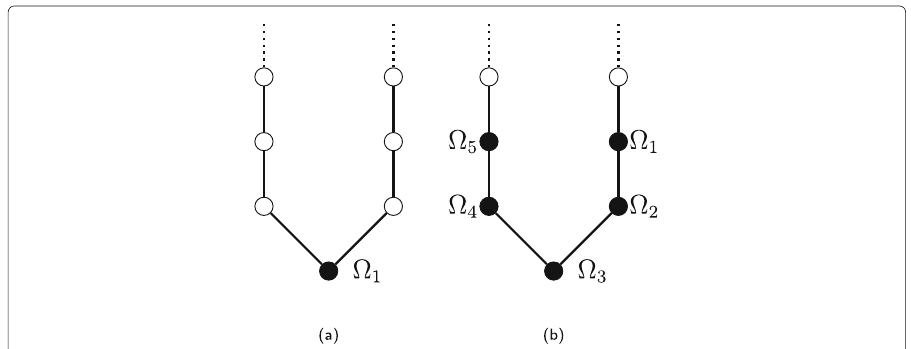
Fig. 5 Schematic of the one-dimensional version of the agent-based model. a Scenario where only one base location is present (in black). b Scenario where multiple base locations are present